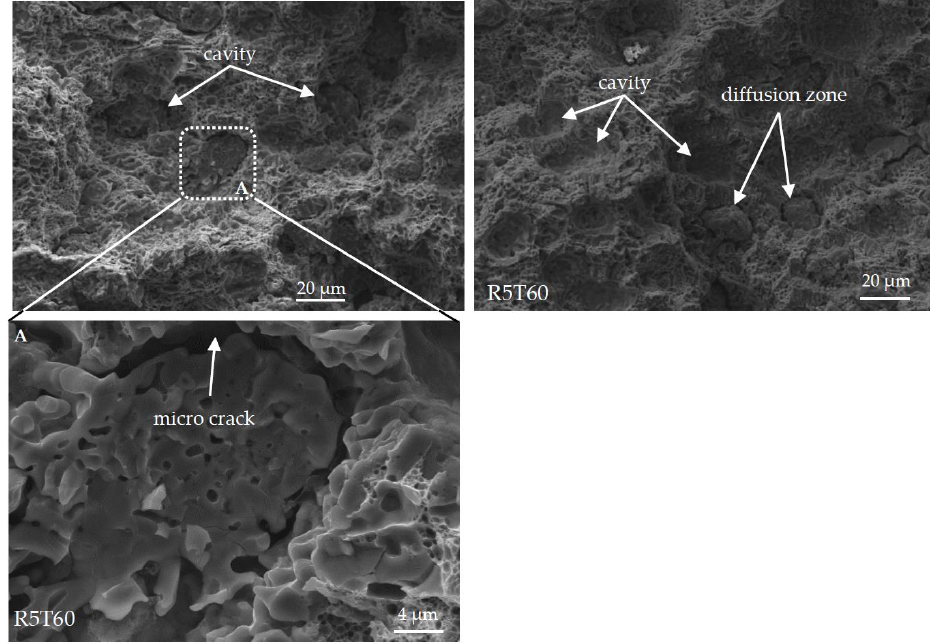
Figure 20. SEM images of fractured surfaces from the 60 min sintered Fe + 5 vol.% B 4 C test specimen, A: the magnified region of the white dashed line.